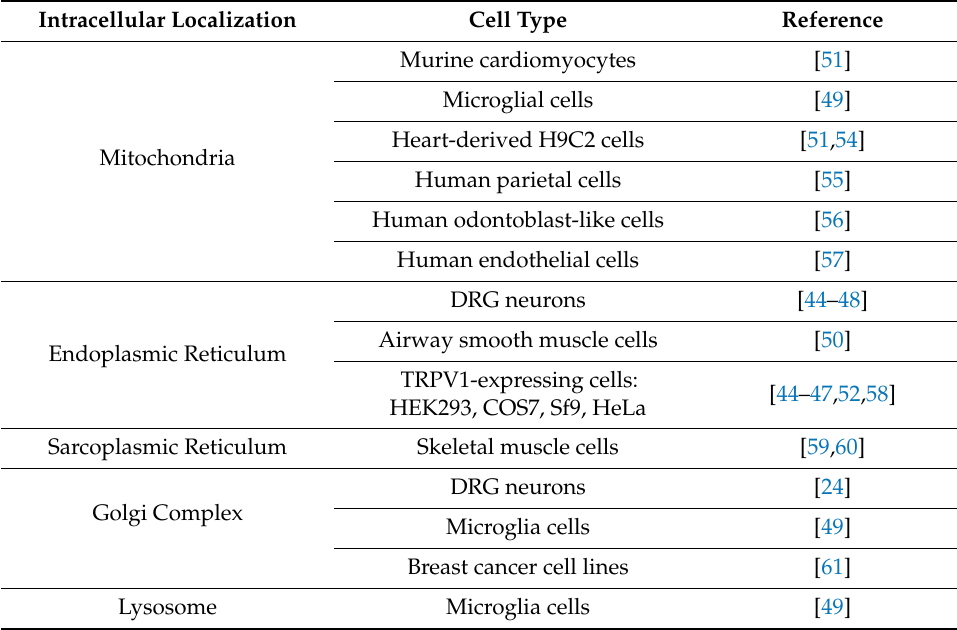
Table 1. Intracellular localization of the TRPV1 channels in di ff erent cell types. DRG: dorsal root